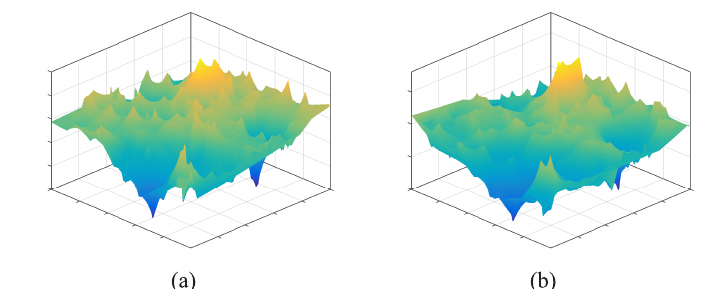
(cid:16) (cid:17) = 0.95 × z + 0.05 + N ( 0,0.06 ) ; z i , j i , j (cid:16) (cid:17) = 0.9 × z 2 + 0.9 × z + 0.1 + N ( 0,0.11 ) z i , j i , j i , j